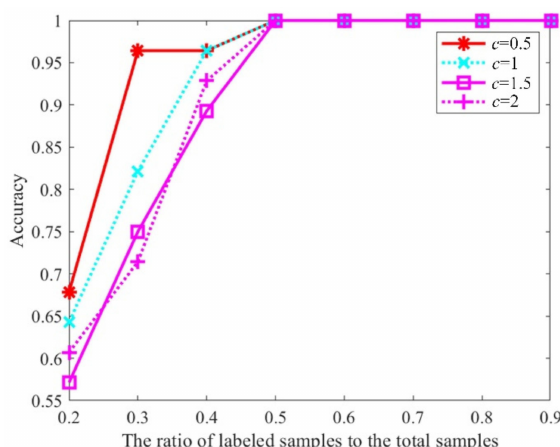
Figure 8. The accuracy of CCT-HTD with different c under different ratios of labeled